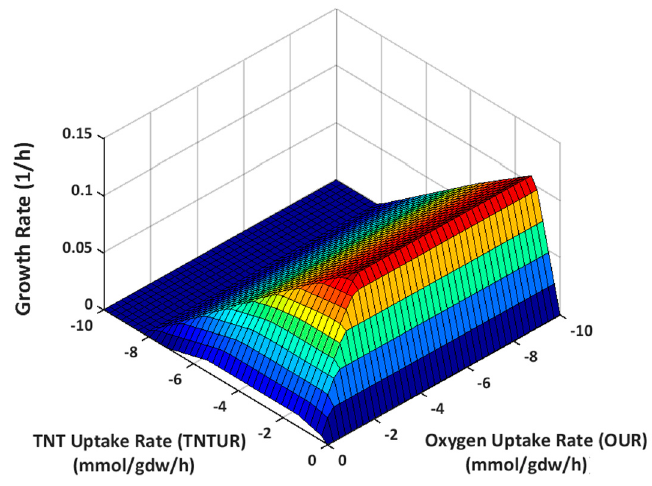
Figure 7. Phenotype phase plane: the growth rate is shown as function of TNTUR and OUR.